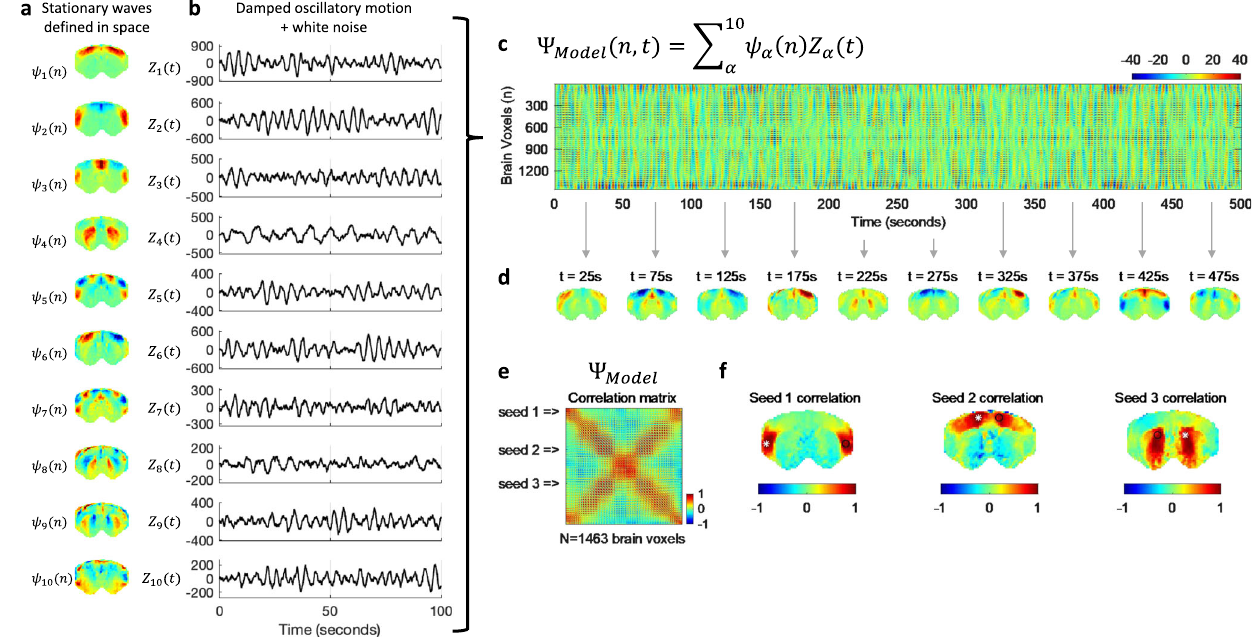
Fig. 8 | Stochastic resonance of standing waves drives transient long-range correlations in simulated signals. The spatial con fi gurations and temporal sig- natures of the principal components align with the hypothesis that they represent standing waves, whose phenomenology is inherently associated with resonance phenomena. To model the dynamics emerging from the transient resonance of standingwavesinthepresenceofbackgroundnoise,foreachofthespatialpatterns detectedinmedetomidine-sedatedrats( a ),wesimulateatemporalsignatureasthe behavior of an underdamped oscillator perturbed with gaussian white noise ( b ). c Multiplying each N ×1 spatial pattern by the corresponding 1× T temporal sig- nature results in an N × T spatiotemporal pattern for each mode. The linearsum of